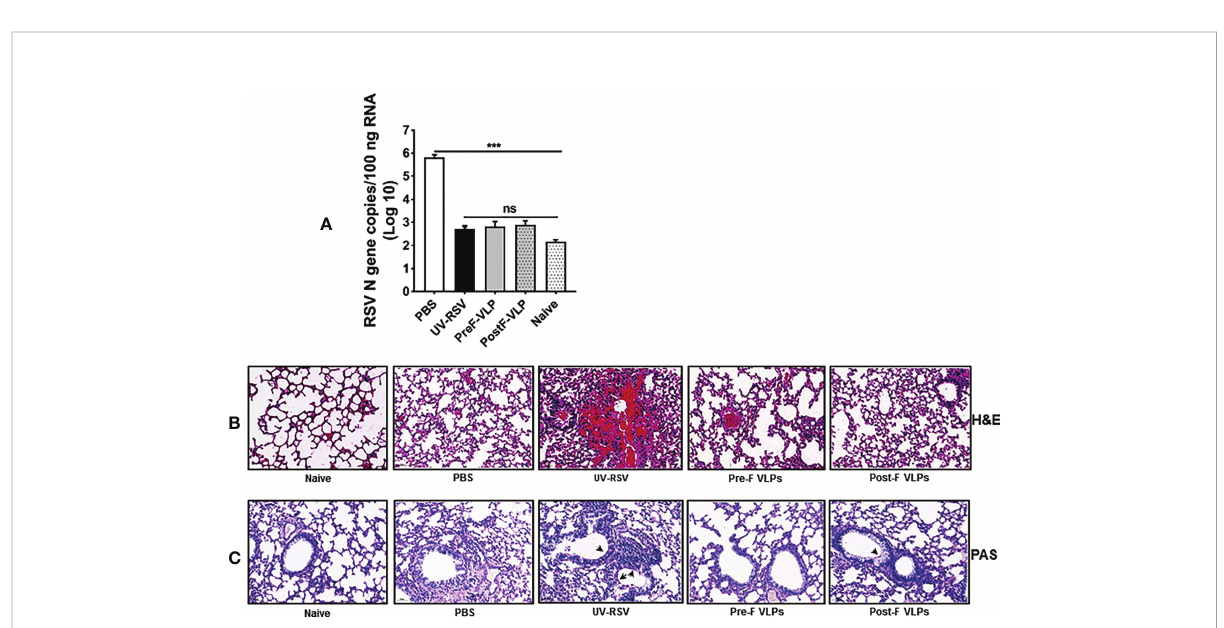
FIGURE 6 RSV load and histopathological analysis of lung tissues from vaccinated mice upon RSV challenge. Mice were immunized i.m. thrice and challenged i.n. with RSV 2 weeks after the fi nal immunization. Lungs were harvested on Day 4 p.c. (A) RSV copy numbers in lung tissues were measured by qRT − PCR. Data are presented as mean values ± SDs for six mice in each group. Pairwise comparisons of values were performed using one-way ANOVA followed by the Tukey test. *** P < 0.001; ** P < 0.01; * P < 0.05; ns, not signi fi cant. (B, C) Representative histopathological section of lung from immunized mice at Day 4 after RSV challenge by haematoxylin-eosin (H&E) (B) and periodic acid-Schiff (PAS) staining (C) for each experimental